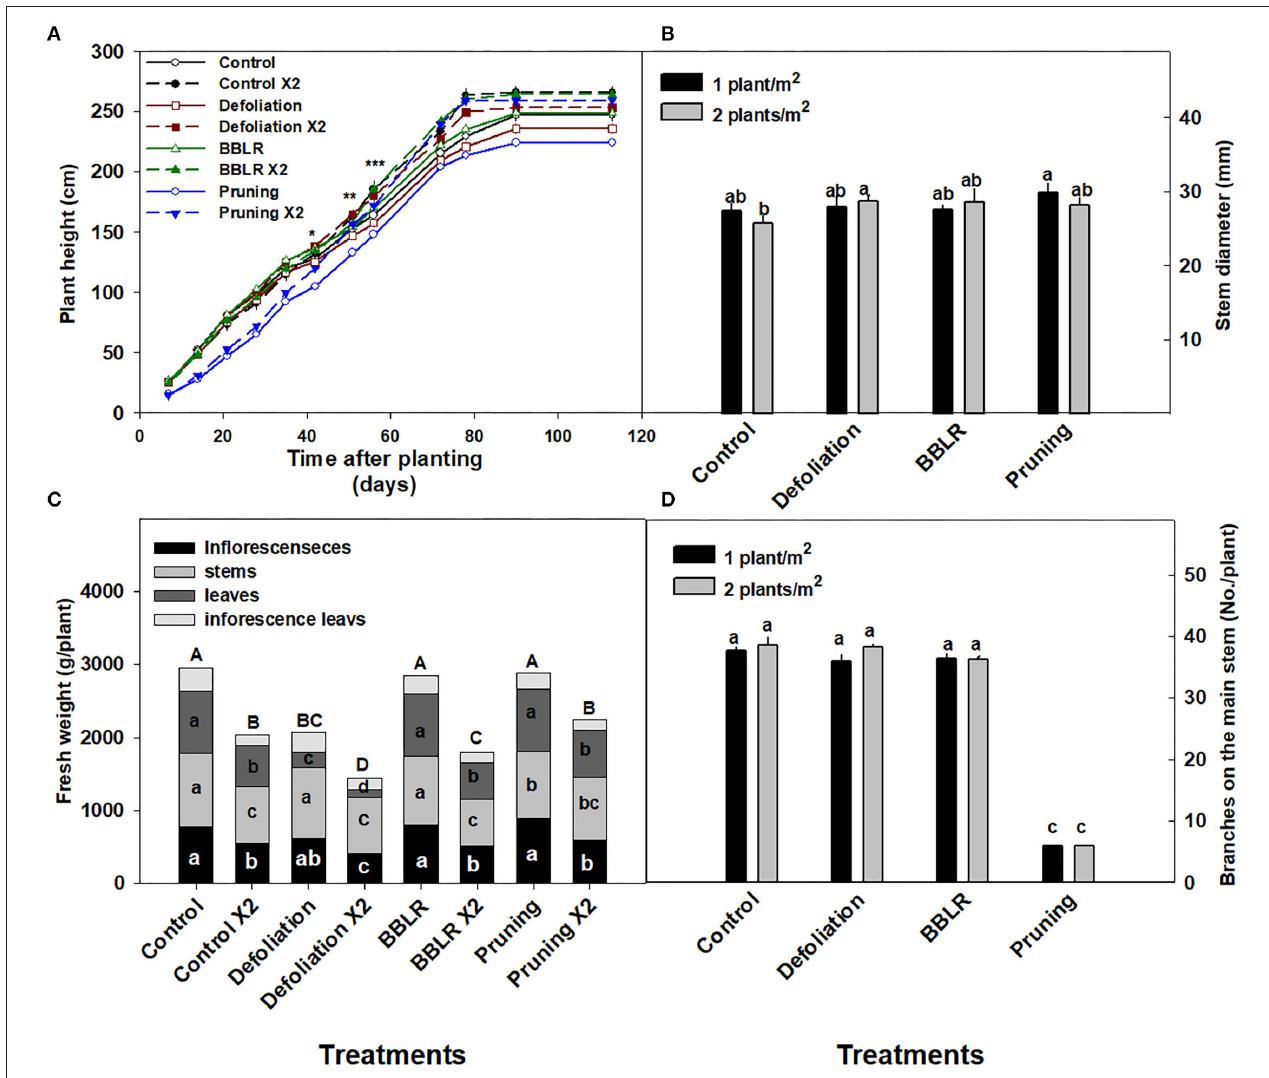
FIGURE 2 | Effects of plant density and architecture modulation treatments on plant morphology. Plant height (A) , biomass of plant organs and of the whole plant (bars) (B) , Stem diameter (C) , and number of branches (D) at harvest. The results are mean ( n = 6) and SE (in C,D ). Different letters above the bars represent significant differences between treatments by Tukey HSD test at α = 0.05. In (A) , asterisks represent the day significant differences were first identified between density treatments within an architecture treatment (*-“Pruning”, **-“Control,” and “Defoliation,” ***-“BBLR”). In (B) , different letters within the bars across a plant organ, represent significant differences between treatments. x 2 represents the density of 2 plants/m 2